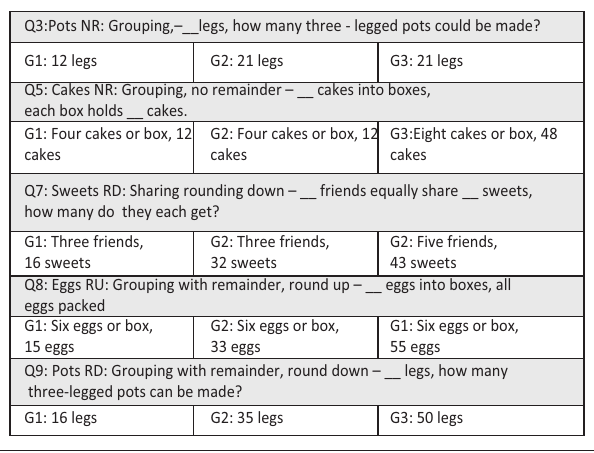
FIGURE 5: Simple direct ratio division problems: Grouping and